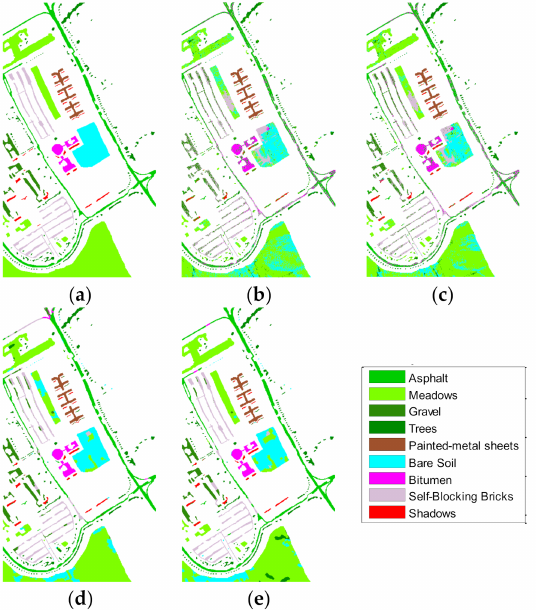
Figure 11. Classification results of different features on PaviaU data: ( a ) label data, ( b ) prediction image of true spectral data, ( c ) prediction image of multi structure feature fusion (MSFF) data, ( d ) pre- diction image of augmented data, and ( e ) prediction image of data combining data augmentation and